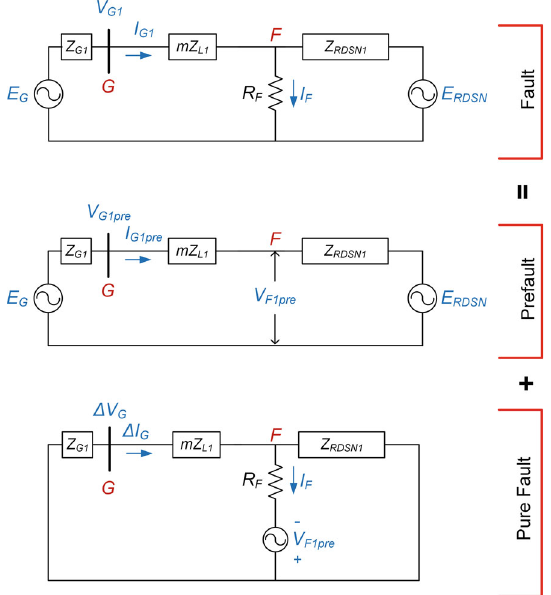
Fig. 10 Superposition theorem used to decompose the network into a prefault and a “pure” fault during a three-phase